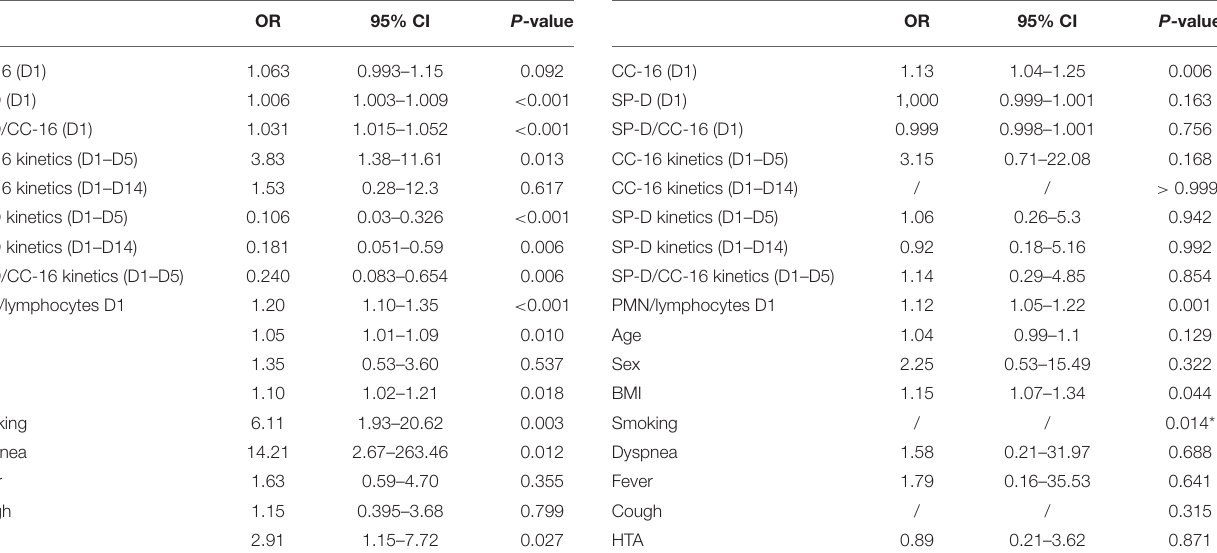
TABLE 3 | Risk for ARDS: Univariate analysis. TABLE 4 | Risk for death: Univariate